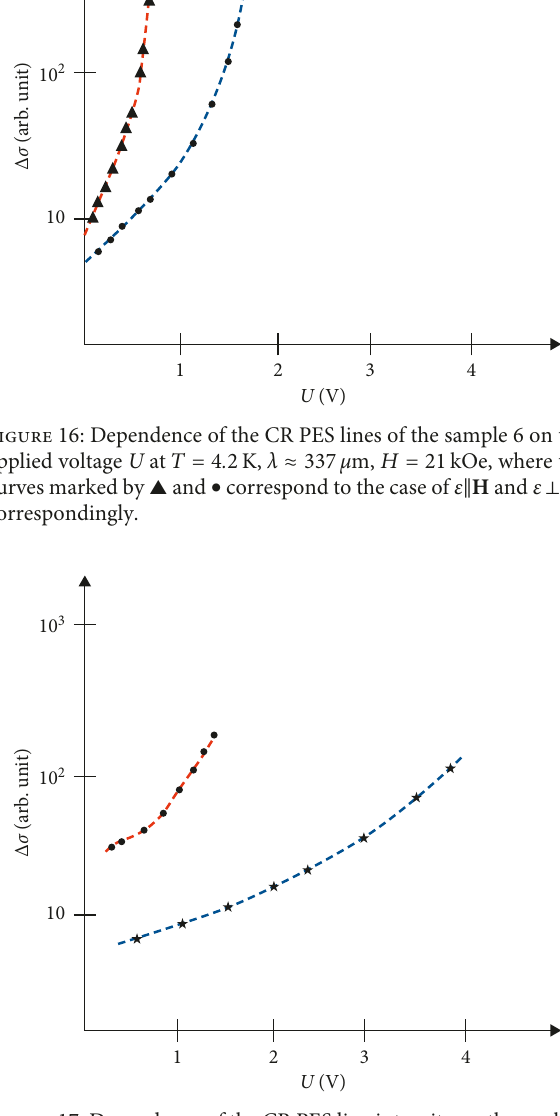
4 . 2 K, λ 119 μ m, H 61kOe, (cid:29) (cid:29) correspond to the case of ε H (cid:25) ≈ ∗